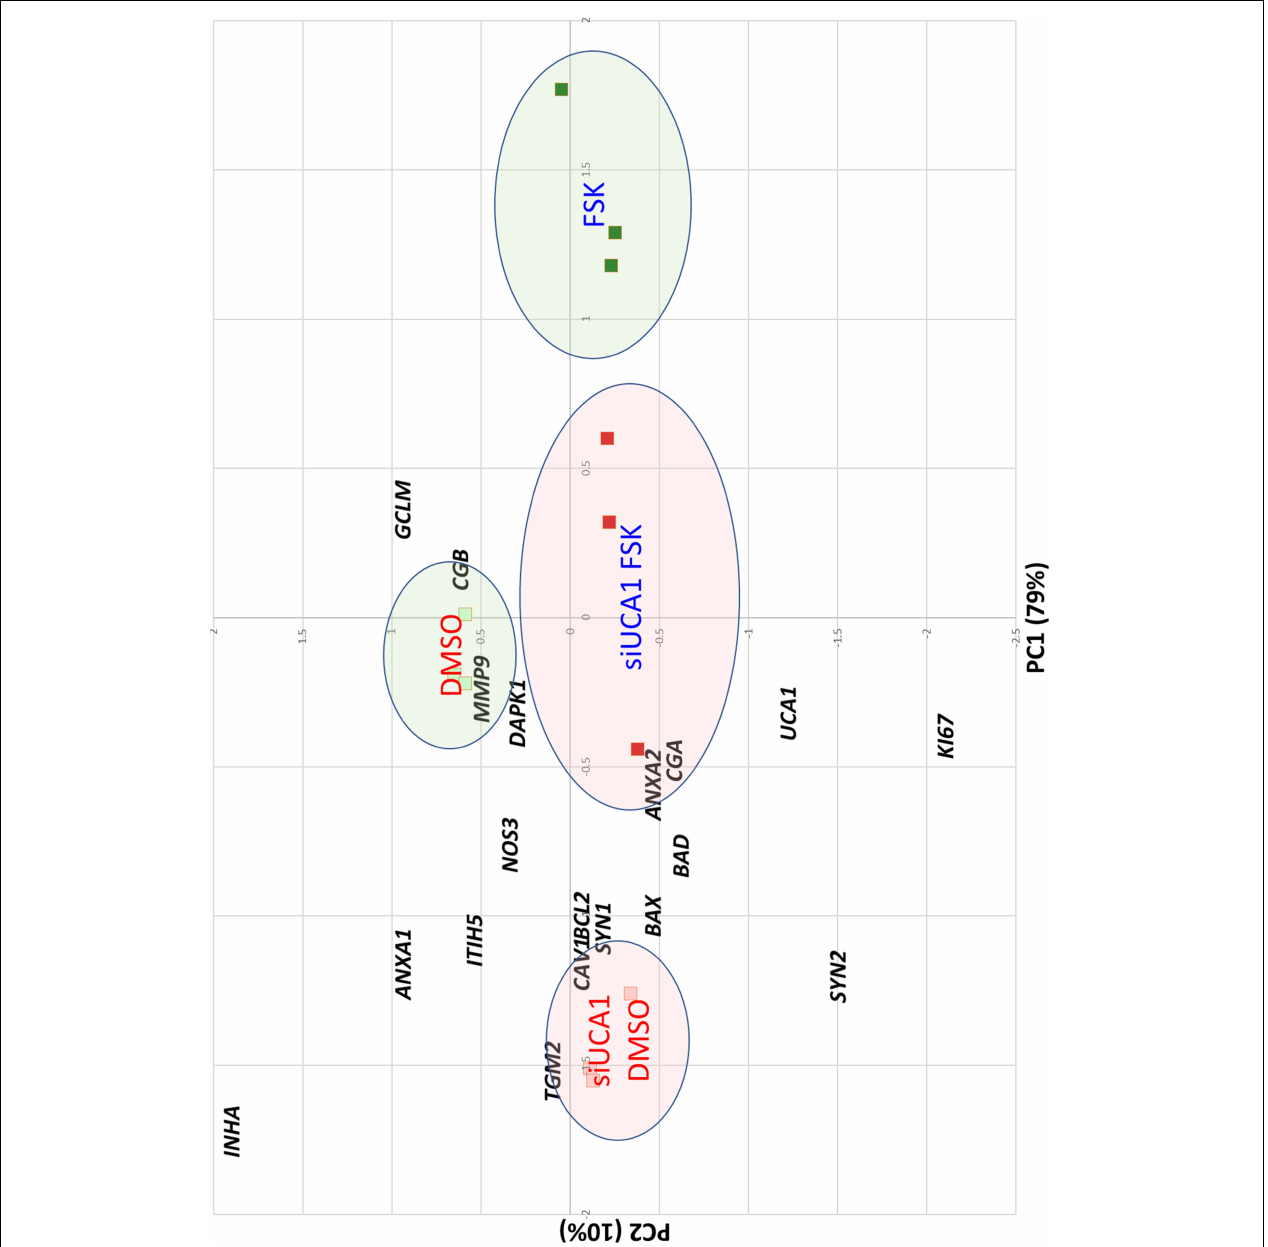
FIGURE 7 | Principal Component Analysis of the BeWo cells treated or not with FSK and with or without the siRNA induced knockdown of UCA1. The squares are the samples analyzed projected on the two major principal components. The genes are projected as well on the factorial plan, to help for interpreting the axes. The horizontal axis is correlated with the cell differentiation induced by FSK. The second axis is rather correlated with cell proliferation. Circles are drawn to easily identify the different categories of treatment. Detailed interpretation is provided in the text.